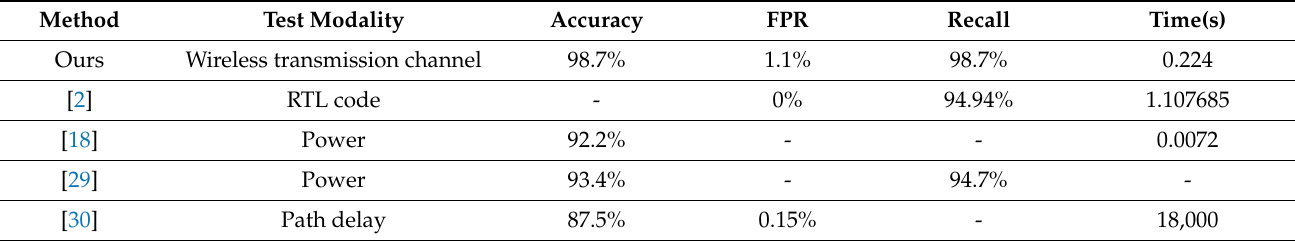
Table 5. Comparison to the existing